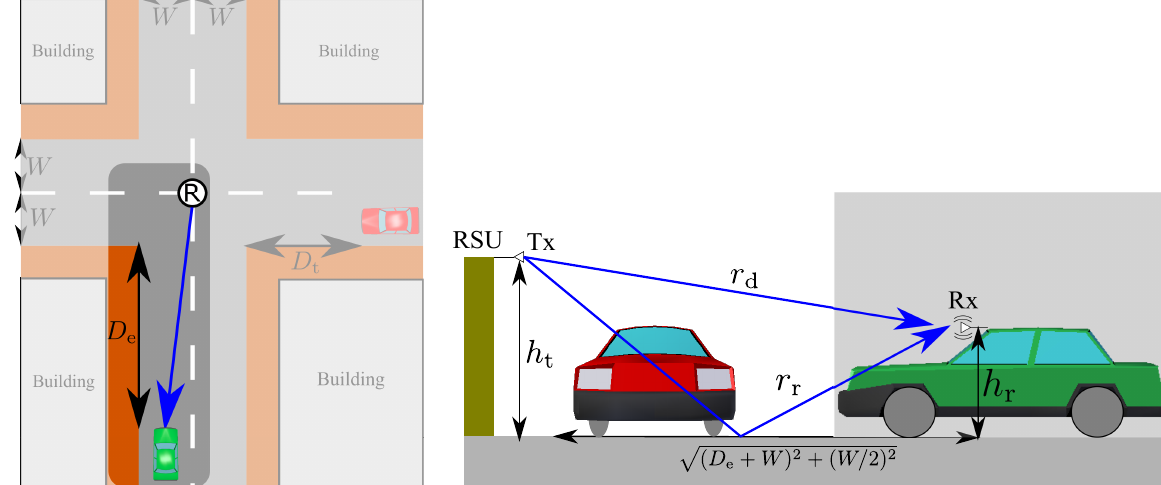
Figure 8. The two-ray ground reflection model with the receiver